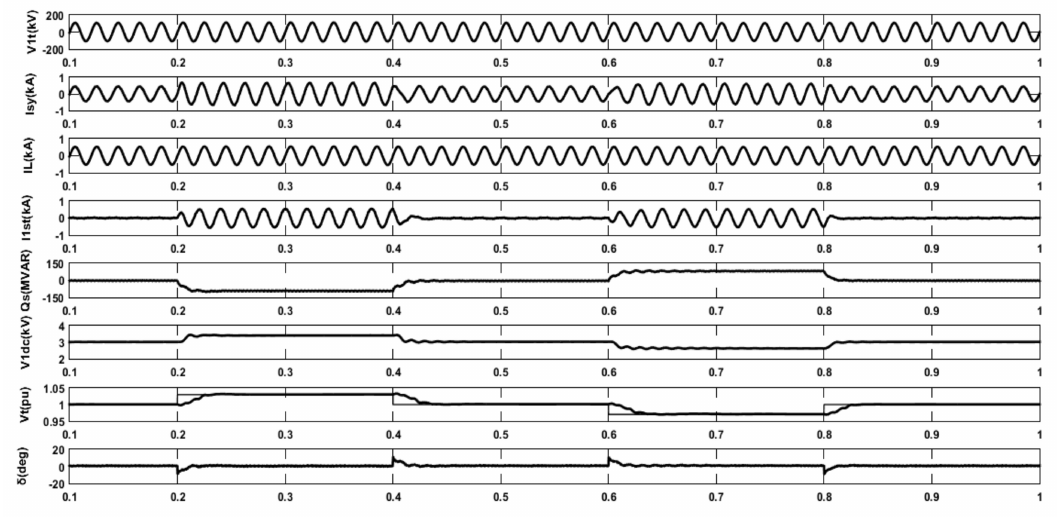
Figure 9. Performance of seven level VSC based STATCOM at terminal voltage variations.